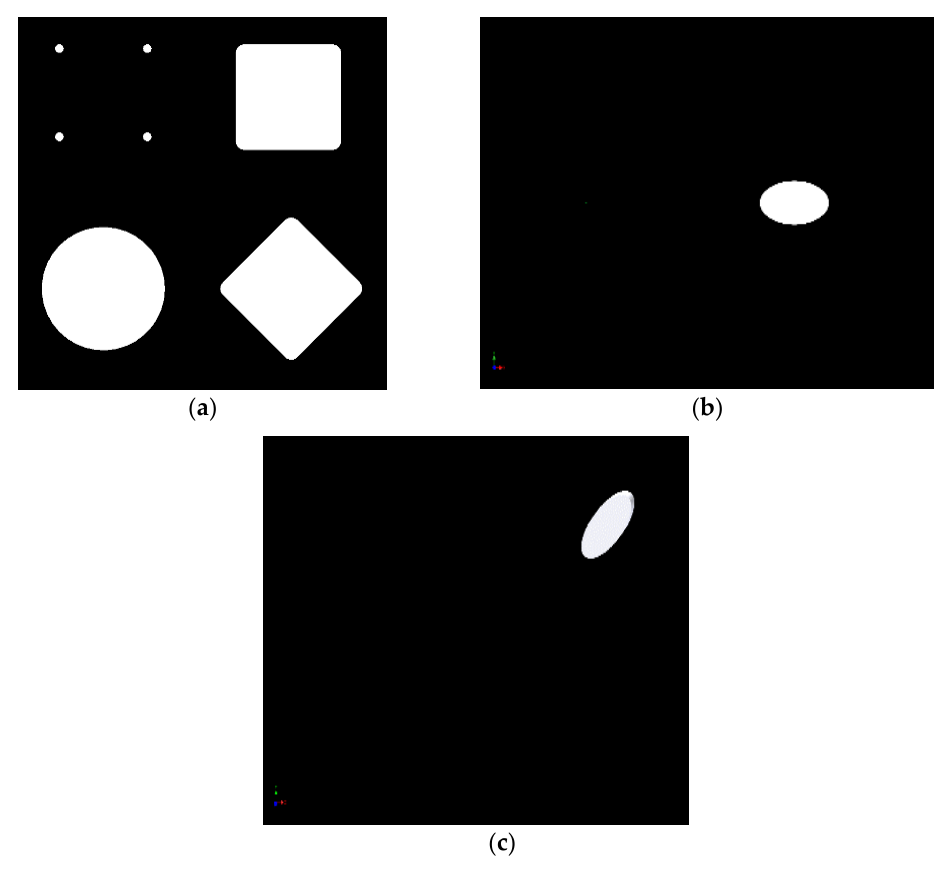
Figure 8. ( a ) Various projection images schematically; ( b ) Deflection of the circle (Figure 6b) on the x - axis schematically; ( c ) Deflection of the circle (Figure 6b) on the x - and y -axis schematically.